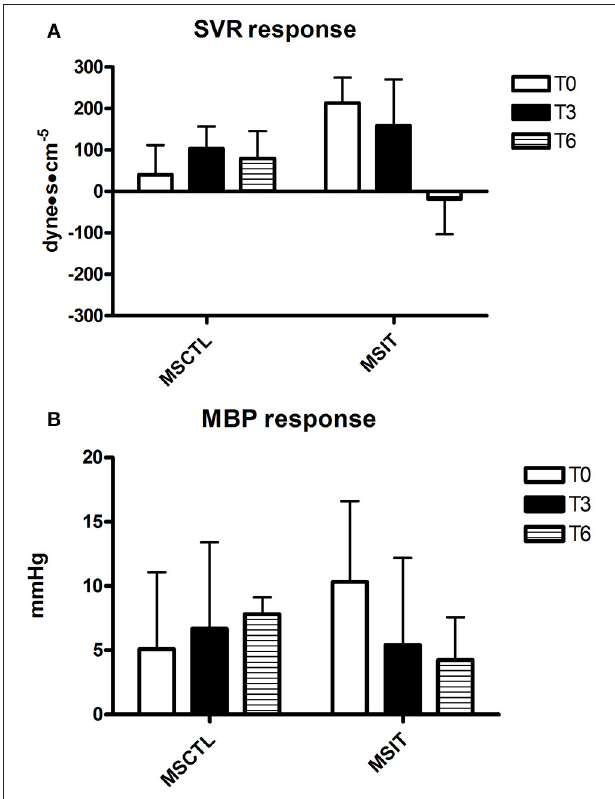
FIGURE 4 | Responses due to metaboreflex activation in MBP (A) and SVR (B) at T0, T3, and T6, respectively. Groups are the MSCTL ( n = 10) and the MSIT ( n = 11). Values are mean ±